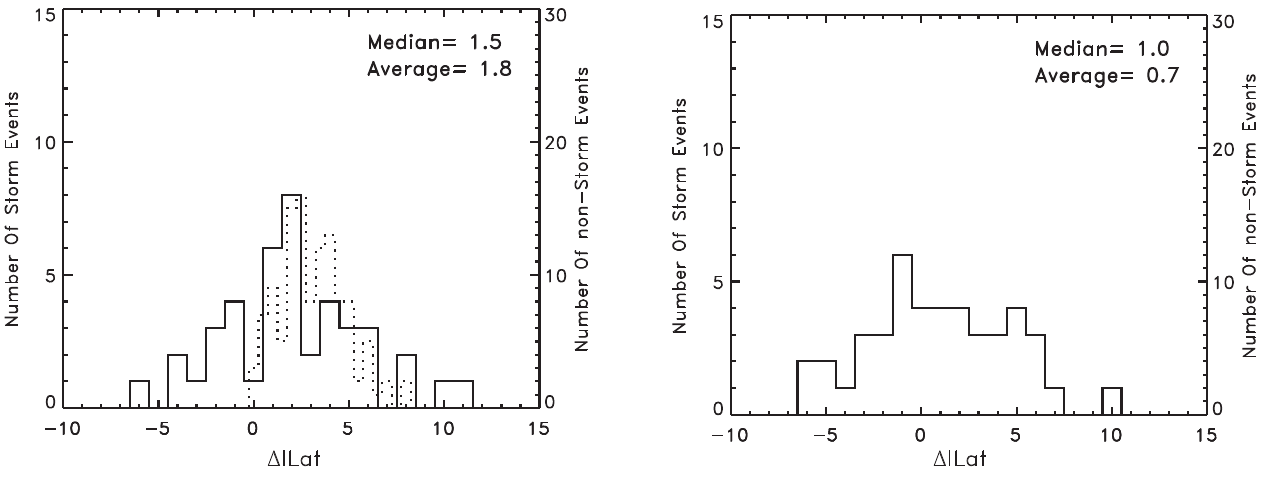
Fig. 9. Histogram of the number of substorms as a function of expansion from a localized onset in 1 ILat, at the west extremity of the auroral events (left) and at the east extremity (right). Superimposed are similar histograms (dotted lines) for isolated substorms, the west end of the surge head (left) and the east end of the bulge (right) (from Gjerloev et al., 2007).